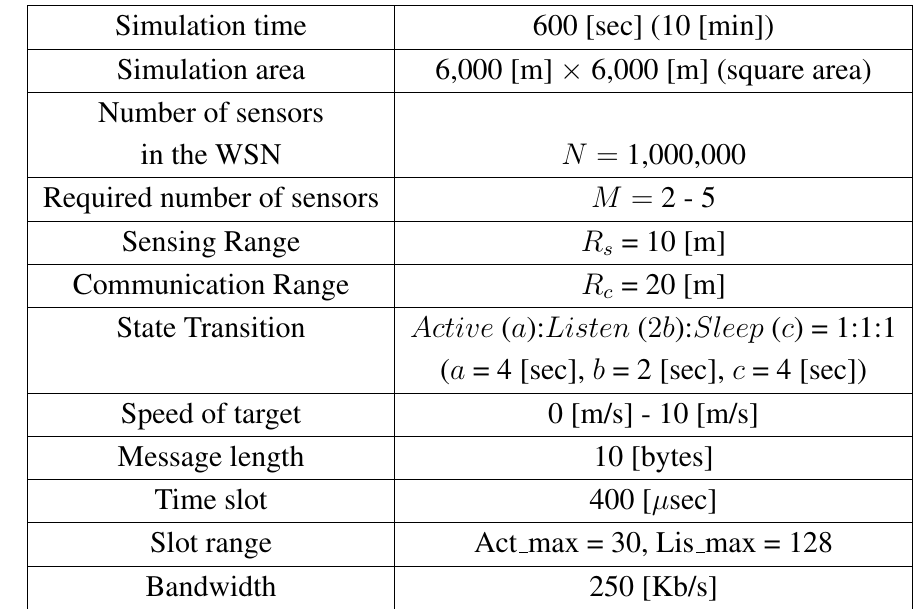
Table 2. Simulation